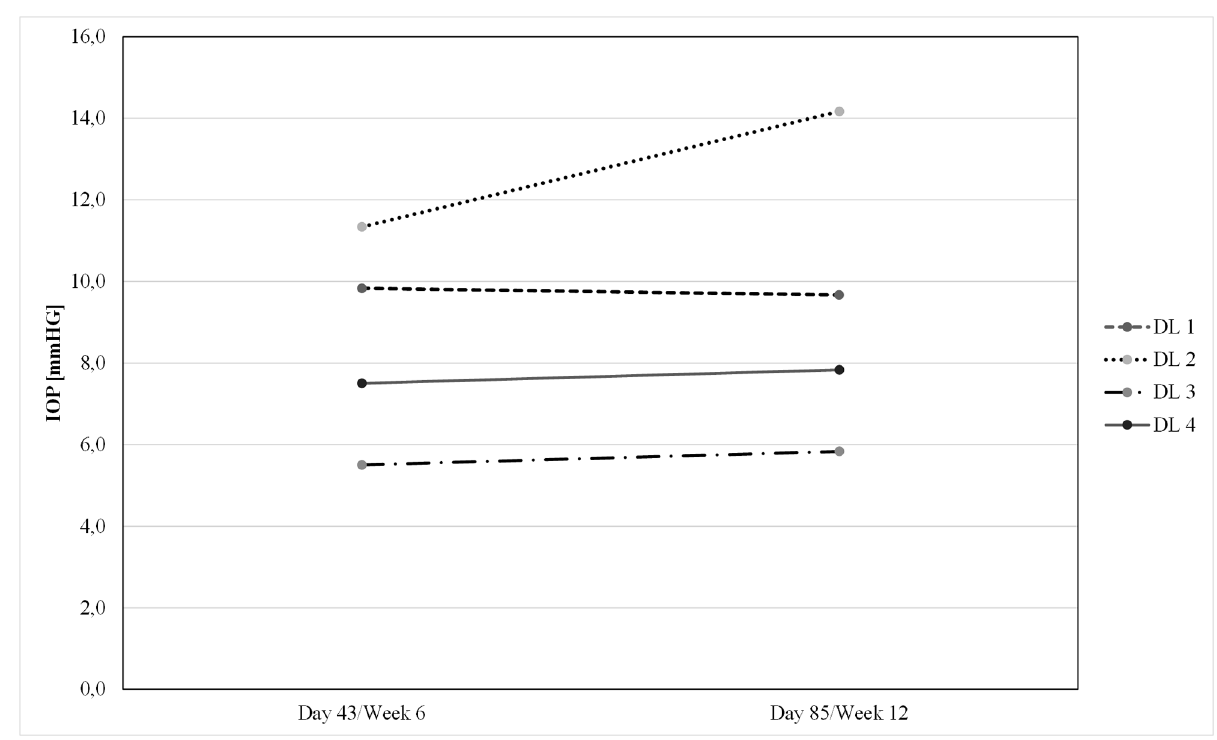
Fig 3. Mean intraocular pressureon Day 43 and Day 85 per dose level.